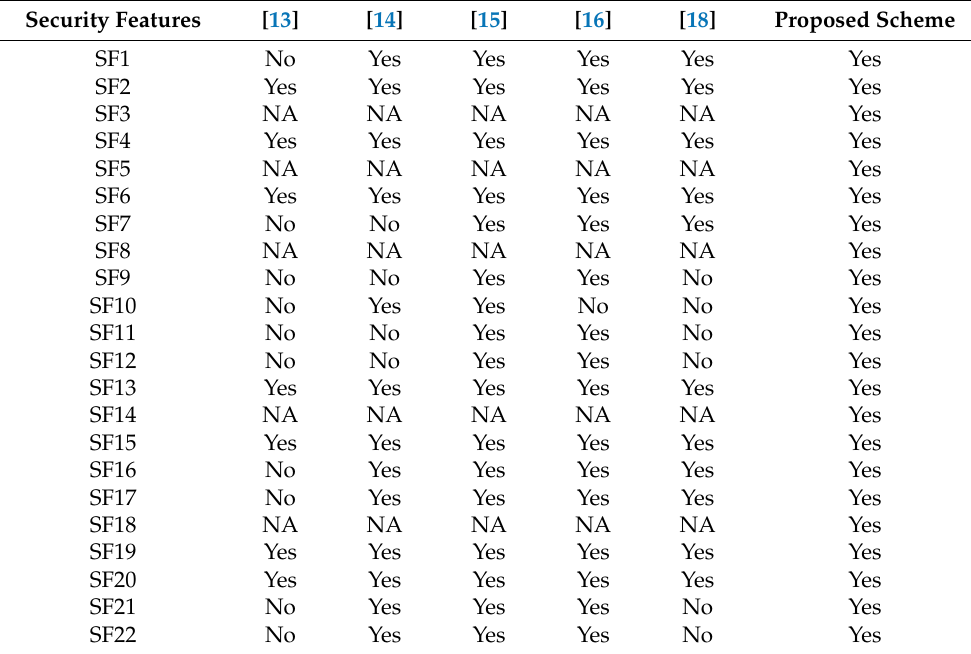
Table 9. Security achievements and resistance to well-known